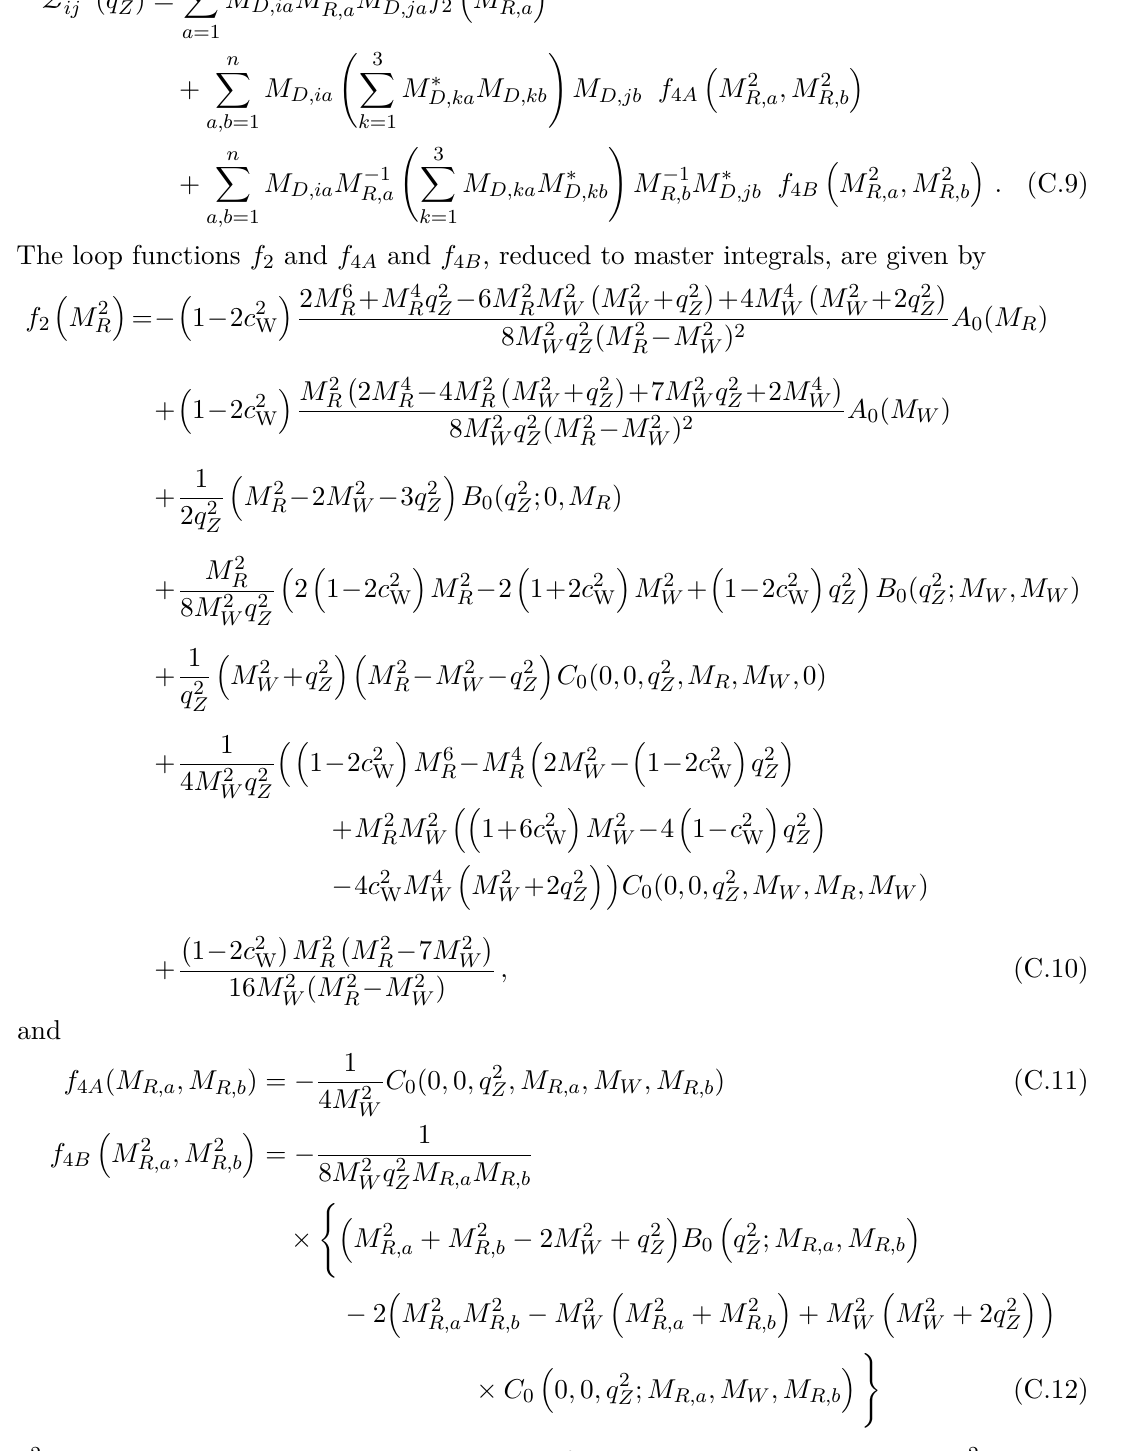
corresponds to the momentum squared of the Z boson. For on-shell Z , q 2 q 2 Z substituted with M 2